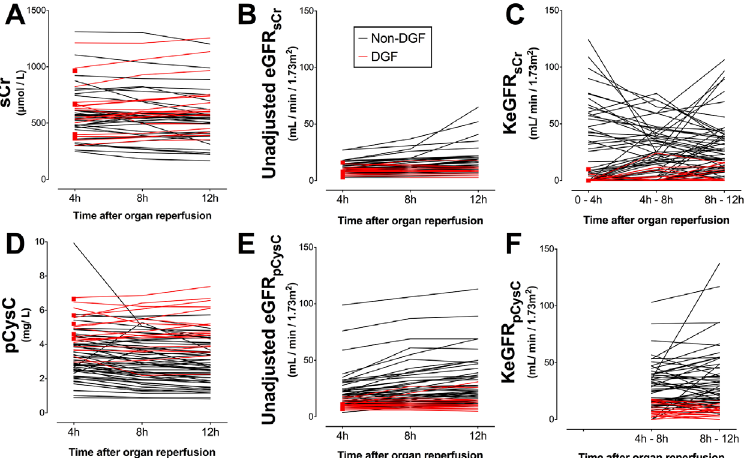
Fig 1. Serum creatinine, plasma cystatin C, unadjusted eGFR and kinetic estimated GFR for each patient. Values for each patient of (A) serum creatinine (sCr), (B) unadjusted estimate of GFR using sCr (eGFR sCr ), (C) kinetic estimate of GFR using sCr (KeGFR sCr ), (D) plasma cystatin C (pCysC), (E) unadjusted estimate of GFR using pCysC (eGFR pCysC ), and (F) kinetic estimate of GFR using pCysC (KeGFR pCysC ). Results are stratified for patients developed delayed graft function, i.e. dialysis requirement within 7 days (red) and those who did not (black). Red squares represent patients who were dialysed before the next timepoint. There is no KeGFR pCysC at 0 – 4h since no 0h pCysC data were available.